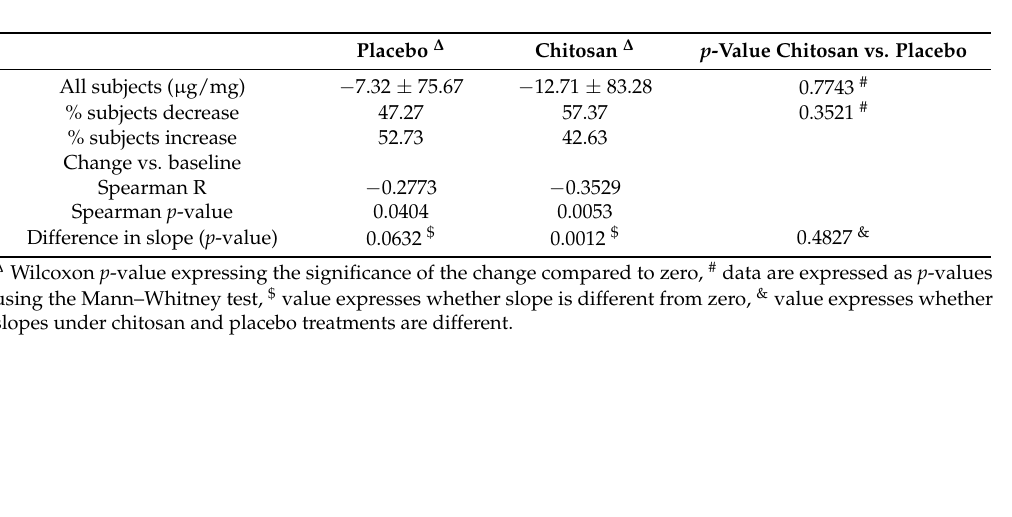
Comparison of changes in R_27-hydroxy-cholesterol induced by chitosan and placebo